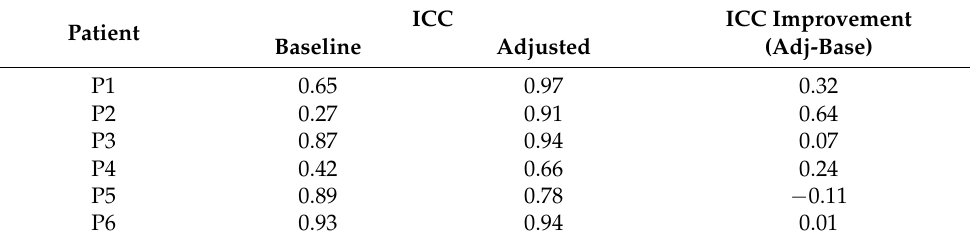
Table 1. Results on the intraclass correlation coefficient (ICC) when using baseline and adjusted camera poses, and improvement in the ICC using adjusted poses. The table shows that the consistency between thermal information from multiple thermal views generally improves using adjusted camera poses, and large improvements are found especially when the baseline ICC consistency is 0.65 or lower .